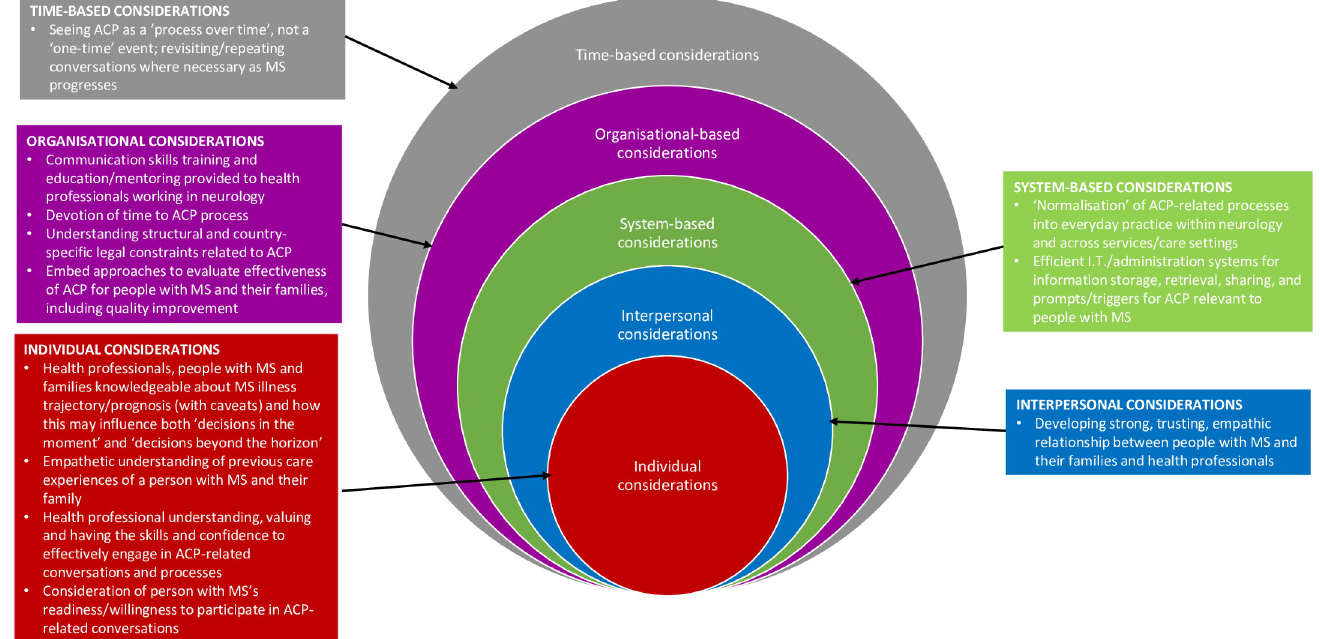
Fig 1. Multi level considerations for advance care planning relevant to people with MS and their